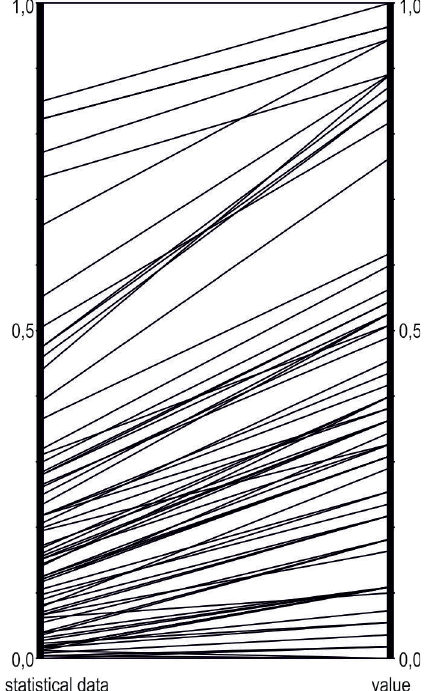
Fig. 4. The axes show the statistical data of the 85 departments and their corresponding value (shading) on the map. Both data strings were normalized in the range 0−1